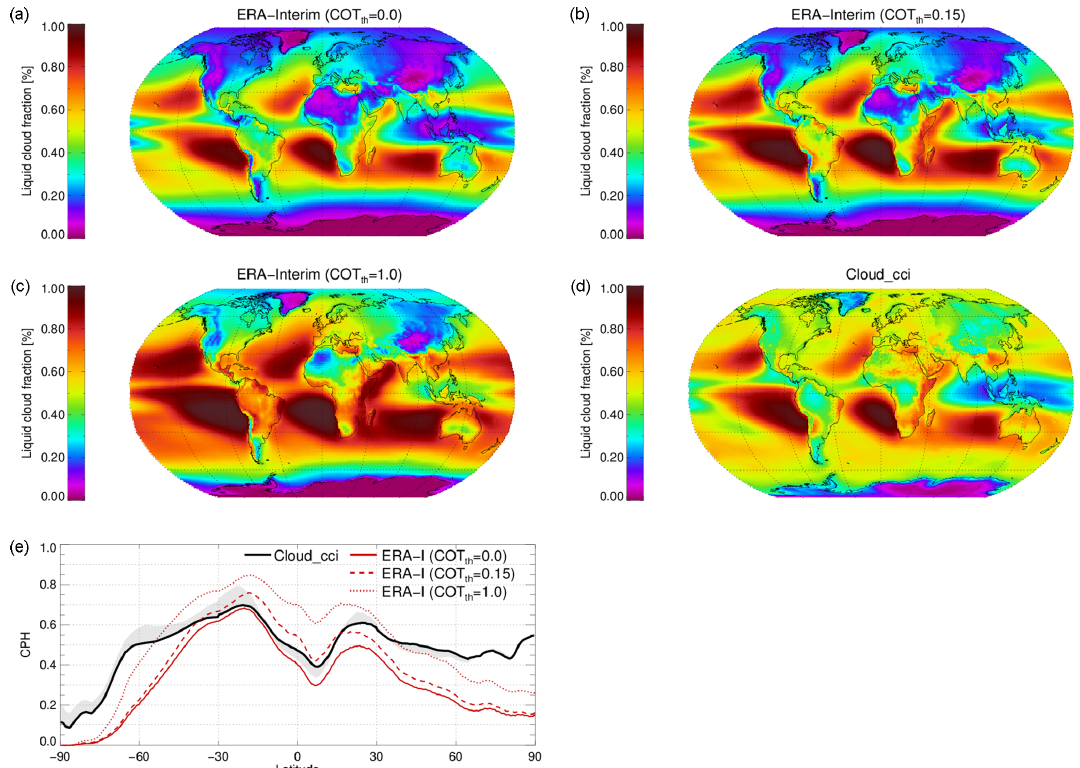
Figure 6. Multi-annual mean cloud phase (CPH), presented as liquid cloud fraction, from ERA-Interim (a–c) and Cloud_cci (d) , where the ERA-Interim liquid cloud fraction was produced by SIMFERA for three top-down optical thickness thresholds (COT th = 0 . 0, 0.15, 1.0), at which the phase was collected from ERA-Interim profiles. (e) Zonal mean plot of CPH for all four sets. The grey shaded area corresponds to the estimated uncertainty in Cloud_cci CPH based on comparisons to